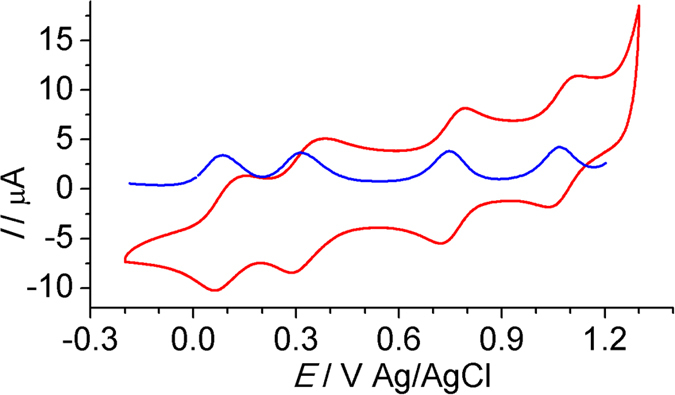
Anodic CV (red curve) and DPV (blue curve) of 2(PF6)3 in 0.1 M Bu4NClO4/CH3CN.